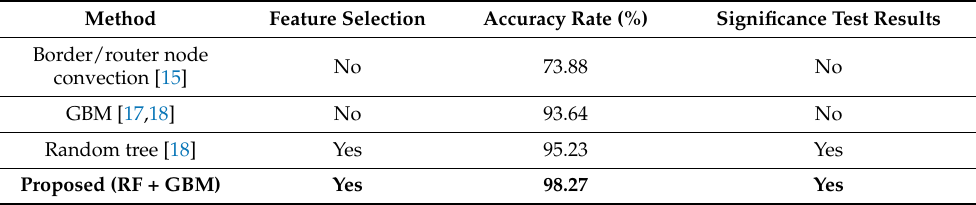
Table 11. Comparison results of proposed model with other